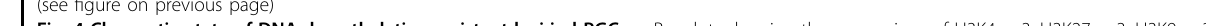
Fig. 4 Chromatin state of DNA demethylation resistant loci in hPGCs. a Boxplots showing the comparison of H3K4me3, H3K27me3, H3K9me3 ChIP-seq pro fi les, expression (FPKM) and DNA methylation level between escapee and demethylated promoters in male and female hPGCs at early stage. b Barplot showing the sum of DNA methylation and expression level rank of retro-transposable elements in hPGCs. Higher rank indicates higher DNA methylation and expression level. SVA, LINE1(L1) and hominoid-restricted ERVs are indicated in red. c Boxplots showing the comparison of H3K4me3, H3K27me3, H3K9me3 ChIP-seq pro fi les, expression and DNA methylation levels between escapee and demethylated repeats in male and female hPGCs at early stage. d Barplots showing histone marks, expression and DNA methylation level in SVA subfamilies in male (top panel) and female (bottom panel) hPGCs at early stage. Left panel: barplot showing H3K4me3 and H3K9me3 preference of each copy of SVA subfamily. Copies with a higher (> 1.33 fold) H3K4me3 signal than H3K9me3 were de fi ned as H3K4me3-marked, while lower (< 0.66 fold) ones were de fi ned as H3K9me3-marked. Middle panel: barplot showing the expression level of each SVA subfamily. Right panel: barplot showing the DNA methylation level of each SVA subfamily. e Boxplots showing the comparison of H3K4me3, H3K27me3, H3K9me3 ChIP-seq pro fi les, expression levels (FPKM) and DNA methylation levels between proximal and distal genes relative to LTR5_Hs/HERVK subfamily (left panel) and LTR14/HERVK subfamily (right panel) in male (top panel) and female (bottom panel) hPGCs at early stage. For male, Wk10 and Wk23 hPGC samples are represented as early and late stage, respectively; for female, Wk10 and Wk21 hPGC samples are represented as early and late stage, respectively. F female, M male, De-methyl demethylated. Student ’ s t test is performed to examine the signi fi cant statistical difference between two groups of data in boxplots in ( a , c and e ). * P < 0.05, ** P < 0.01, *** P < 0.001, n.s. not signi fi